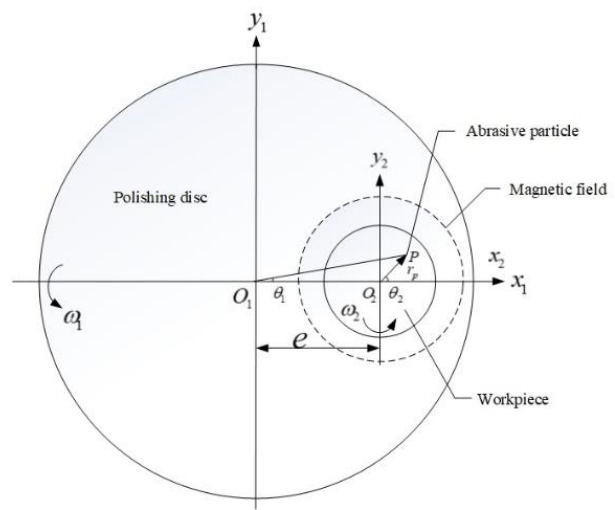
Figure 15. Kinematic MRPF model.